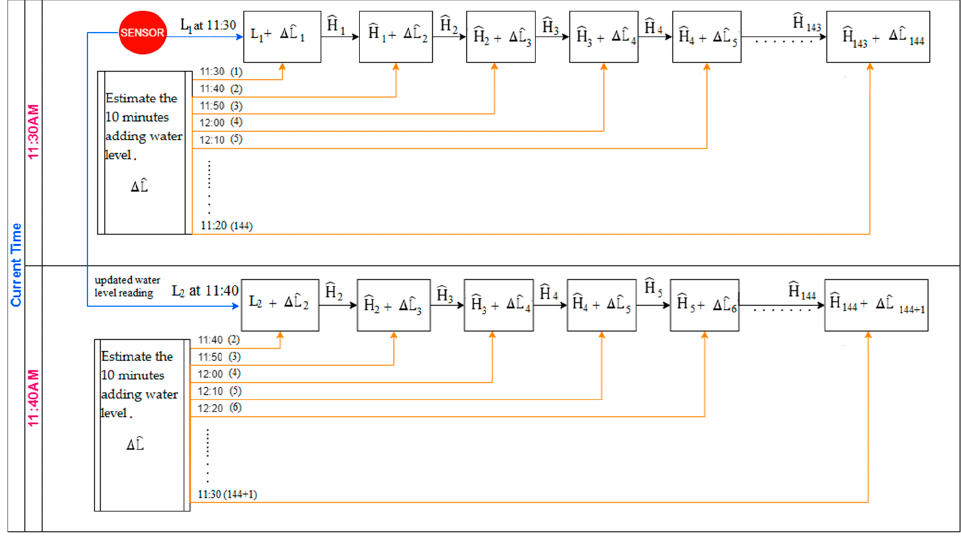
Figure 12. The rolling forecast model in EFWS. Table 2. The rolling forecast model